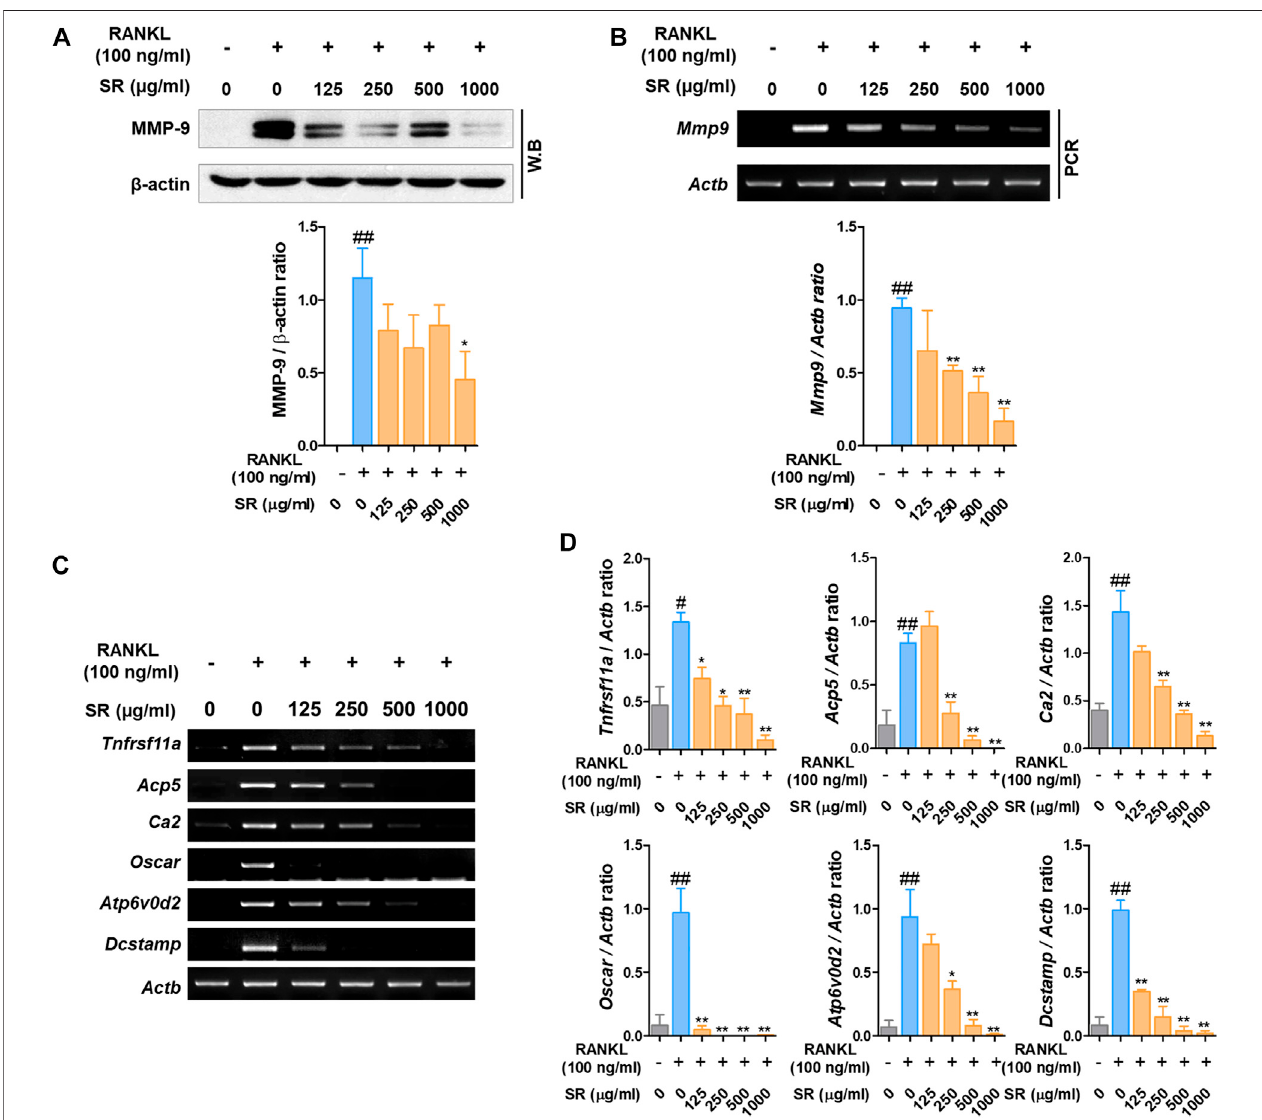
FIGURE5| TheeffectsofSRontheexpressionofosteoclast-relatedgenesinRANKL-inducedRAW264.7cells. (A) ProteinexpressionofMMP-9wasdetermined using Western blotting and (B) mRNA expression of MMP-9 ( Mmp9 ) was determined using RT-PCR. The bands were normalized to that of β -actin ( Actb ). (C) mRNA expression of RANK ( Tnfrsf11a ), TRAP ( Acp5 ), CA2 ( Ca2 ), OSCAR ( Oscar ), ATP6v0d2 ( Atp6vod2 ) and DC-STAMP ( Dcstamp ) was determined using RT-PCR. (D) The bands were normalized to that of β -actin ( Actb ). Data are presented as the mean ± SD of three independent experiments. Statistical analysis was performed using one-way ANOVA followed by Dunnett ’ s post hoc test. # p < 0.05, ## p < 0.01 vs. the normal group (untreated cells); * p < 0.05, ** p < 0.01 vs. the RANKL only treatment group.